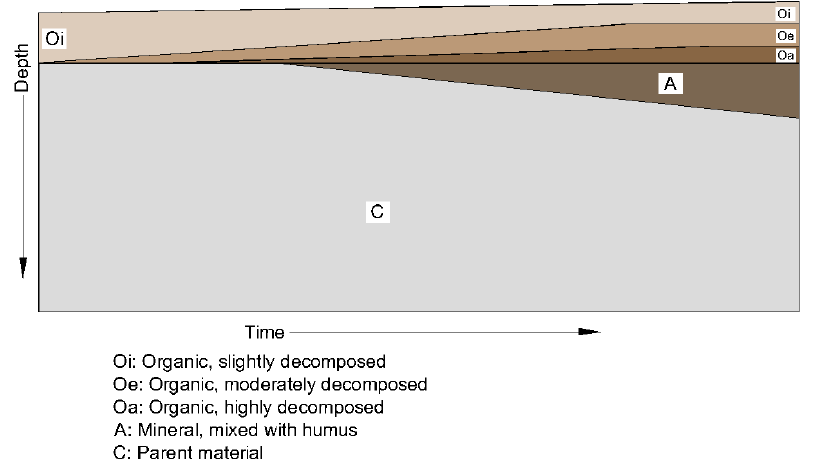
Figure 1. Conceptual illustration of the initial stages of pedogenesis, after Brady and Weil [2]. An organic (O) horizon forms at the soil surface (commonly referred to as the “litter layer”) and is gradually broken down and incorporated into the uppermost soil layer, forming an A horizon (commonly referred to as